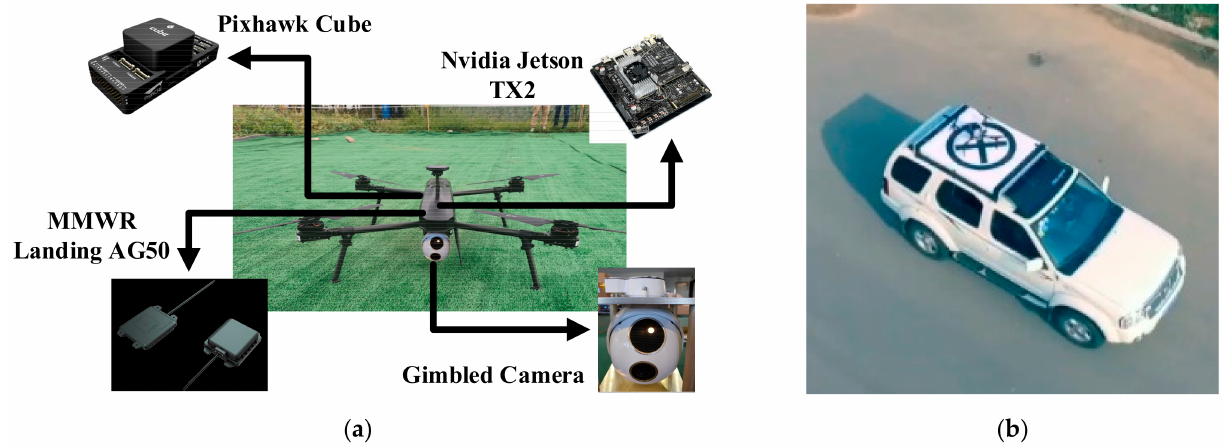
Figure 18. Quadrotor ( a ) and landing platform ( b ) used during landing